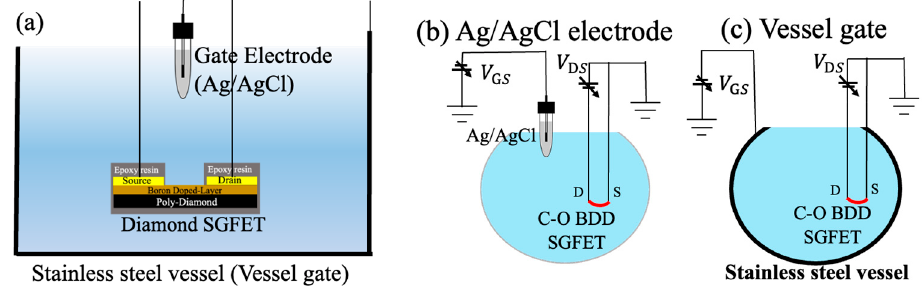
Figure 1. ( a )The cross-sectional view of C-O BDD SGFETs in an electrolyte solution with Ag/AgCl electrode and vessel gate. The measurement schematic images: ( b ) Ag/AgCl electrode and ( c ) vessel gate. In the case of ( b ) Ag/AgCl electrode, the gate voltage is applied between the tip of the electrode and the FET channel which is the sensing surface. In the case of ( c ) vessel gate, the entire stainless-steel surface also becomes the sensing surface.